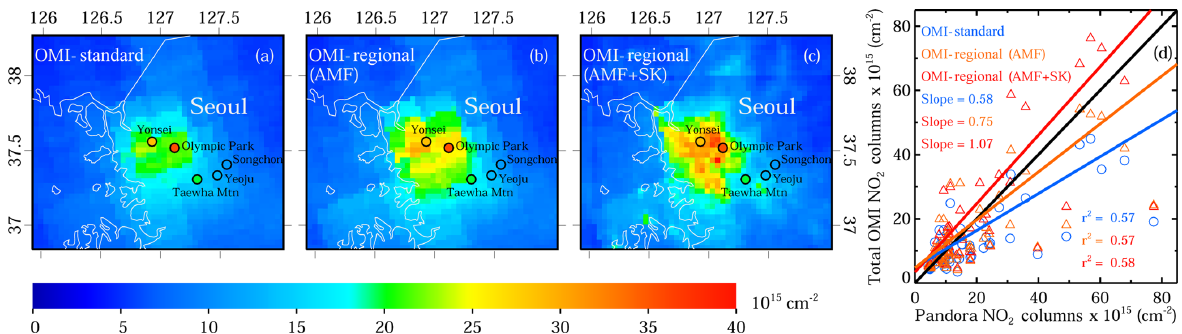
Figure 6. (a) Total vertical column contents from the OMI-standard NO 2 product for May 2016, (b) same quantities from the OMI-regional product with only the air mass factor adjustment (AMF) during the same time frame, (c) same quantities from the OMI-regional product with the air mass factor adjustment and spatial kernel (AMF + SK) during the same time frame, and (d) a comparison between total column contents from the three OMI NO 2 products and Pandora NO 2 during May 2016. An average of Pandora 2h means co-located to valid daily OMI overpasses are overlaid in the spatial plots.